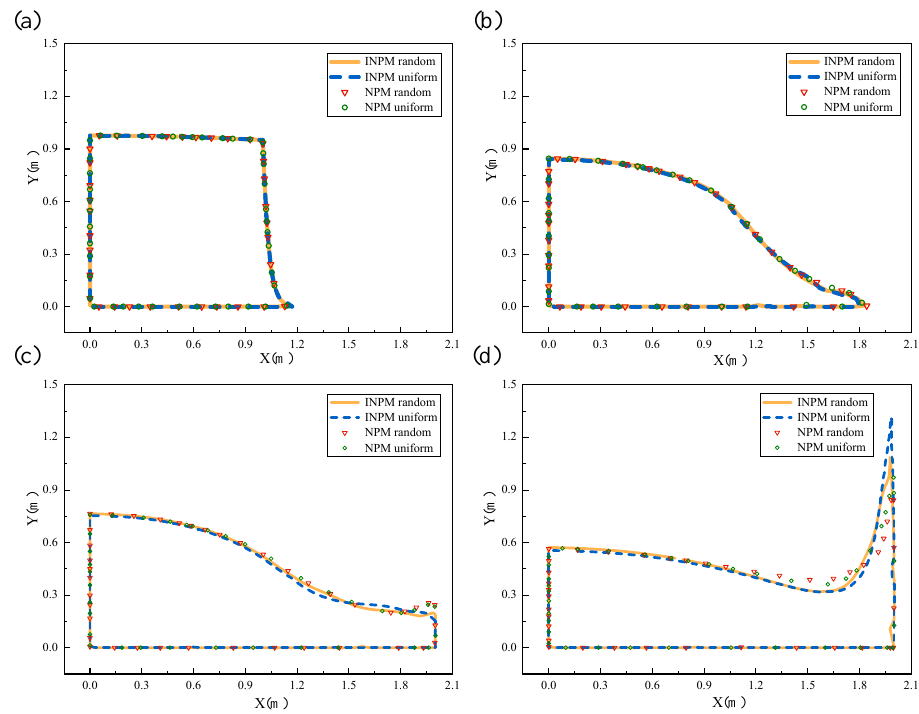
Figure 5. Comparison of simulation results of the fluid boundary using the improved NPM and NPM with different particle distributions. Simulation results at ( a ) t = 0.1 s; ( b ) t = 0.3 s; ( c ) t = 0.4 s; ( d ) t = 0.5